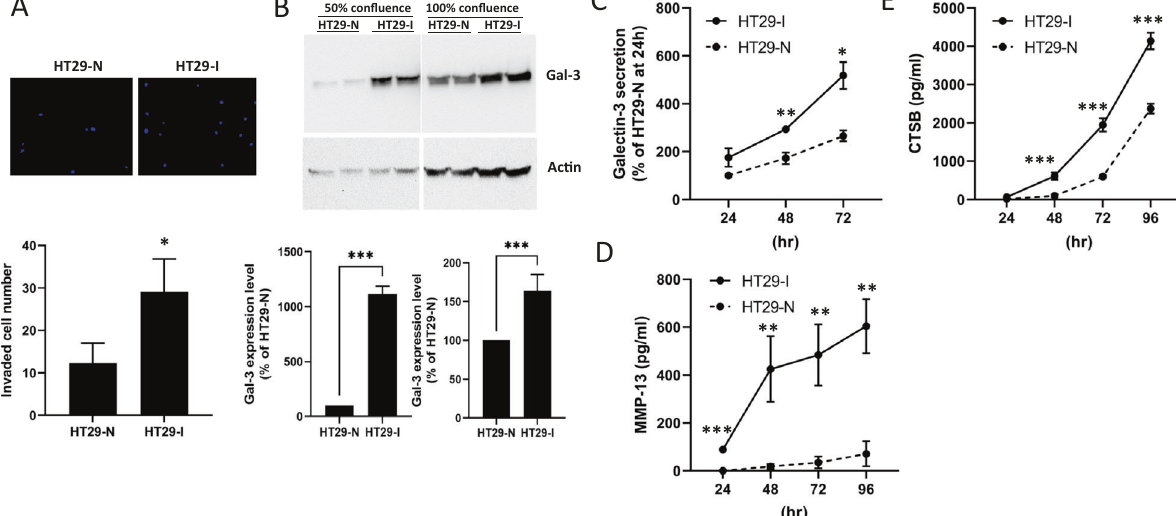
Fig. 4 Galectin-3 expression and secretion promotes protease secretion and cell invasion of HT29 colon cancer cells. A HT29 cells were separated into invasive (HT29-I) and less/non-invasive (HT29-N) sub-populations. HT29-I cells express ( B ) and secrete ( C ) higher amounts of galectin-3 than the non-invasive HT29-N cells when assessed by immunoblotting ( B ) and ELISA ( C ). Representative blots from four experiments are shown in B (Top panels) with band densities shown as percentage galectin-3 expression (Bottom panels) HT29-I cells secrete higher amounts of MMP-13 ( D ) and CTSB ( E ) than HT29-N cells when assessed by ELISA. Data are presented as mean ± SD from three independent experiments, each in triplicate. *** P < 0.001, ** P < 0.01, * P < 0.05 (ANOVA). analysed with protease arrays. SW620 and HCT116 cells were RESULTS cultured in the presence or absence of 10 μ g/ml galectin-3, a Galectin-3 induces protease secretions in human colon cancer concentration that is close to that seen in the circulation of cells colon cancer patients with metastasis [22] for 24 h, and the To assess effect of galectin-3 on protease secretion from cancer concentrations of proteases in the media was measured by the cells, human colon cancer SW620 and HCT116 cells were fi rst Cell Death and Disease (2023)